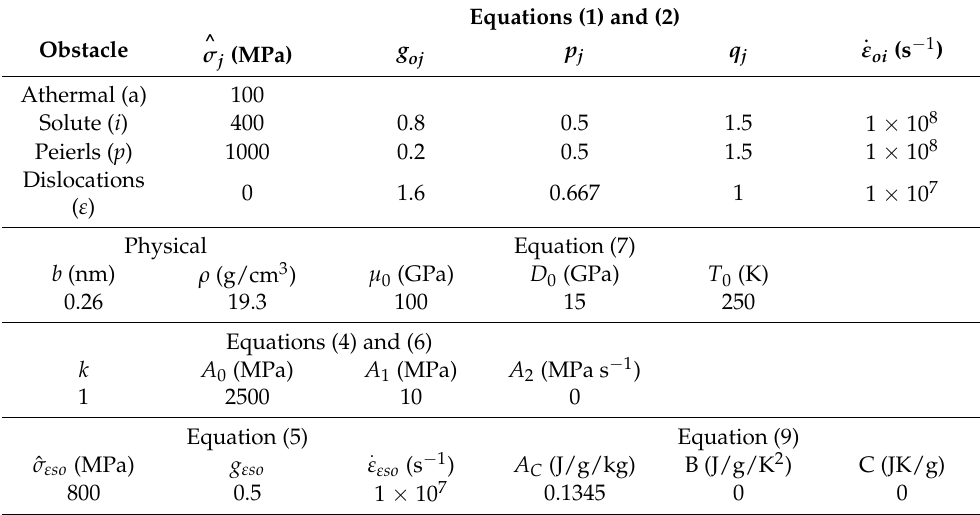
Table 2. MTS model parameters for the hypothetical Follyalloy.